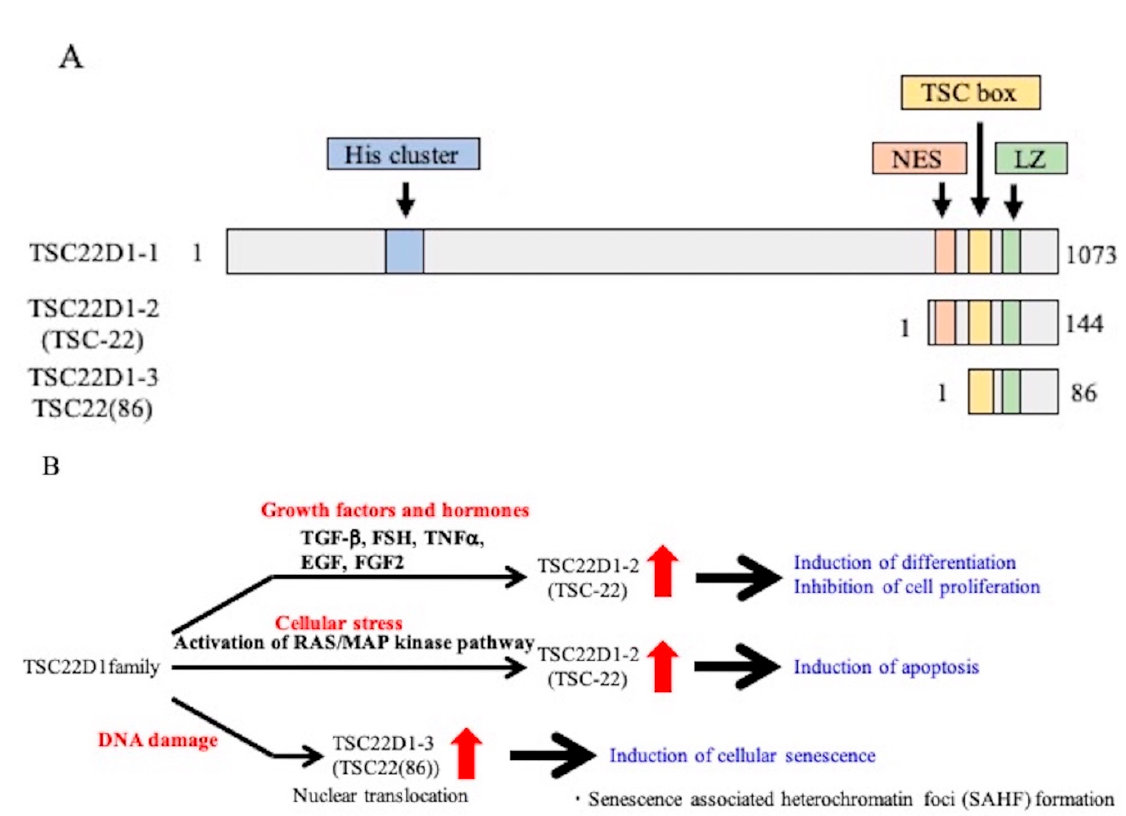
Figure 1. Structure and function of TSC22D1 family proteins. ( A ): Structures of TSC22D1-1, TSC22D1-2 (TSC-22), and TSC22D1-3 (TSC22(86)). TSC22D1-1 has 1,073 amino acids, a His cluster in the N-terminal region, and a nuclear export signal (NES), TSC-box, and leucine zipper (LZ) close to the C-terminus. TSC22D1-2 has 144 amino acids of the C-terminal of TSC22D1-1 and an NES in the N-terminal region and a TSC-box and LZ close to the C-terminus. TSC22D1-3 has 86 amino acids of the C-terminal of TSC22D1-2, lacks an NES, but has a TSC-box and LZ. ( B ): Functions of the TSC22D1 family. Expression of TSC-22 (TSC22D1-2) is increased by growth factors; the protein induces cell differentiation, inhibits cell proliferation, and induces apoptosis. TSC22(86) (TSC22D1-3) induces cell senescence.